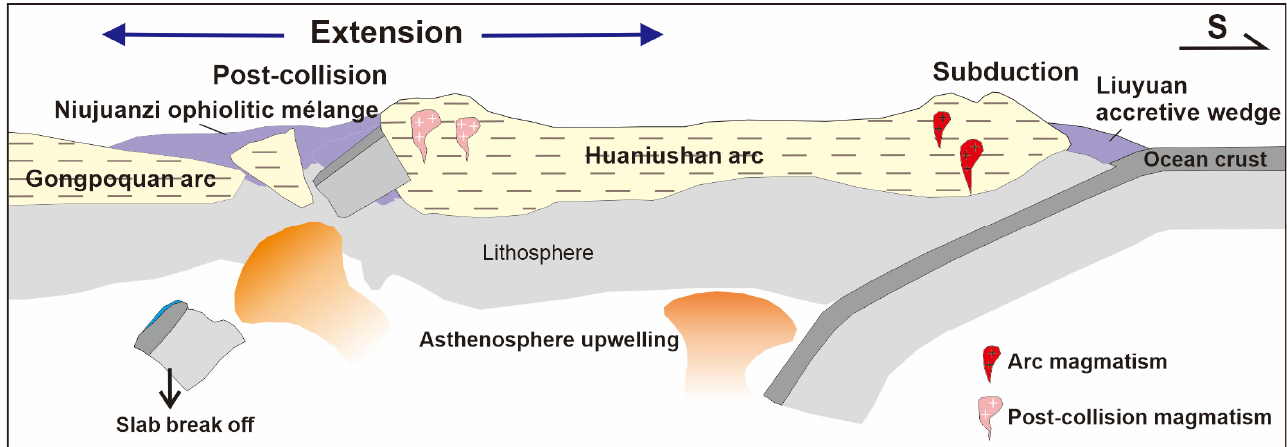
Figure 12. Simplified schematic model of the formation of Late Paleozoic granitoids from the middle Huaniushan arc and tectonic-magmatic evolution of the Southern Beishan Orogenic Belt.